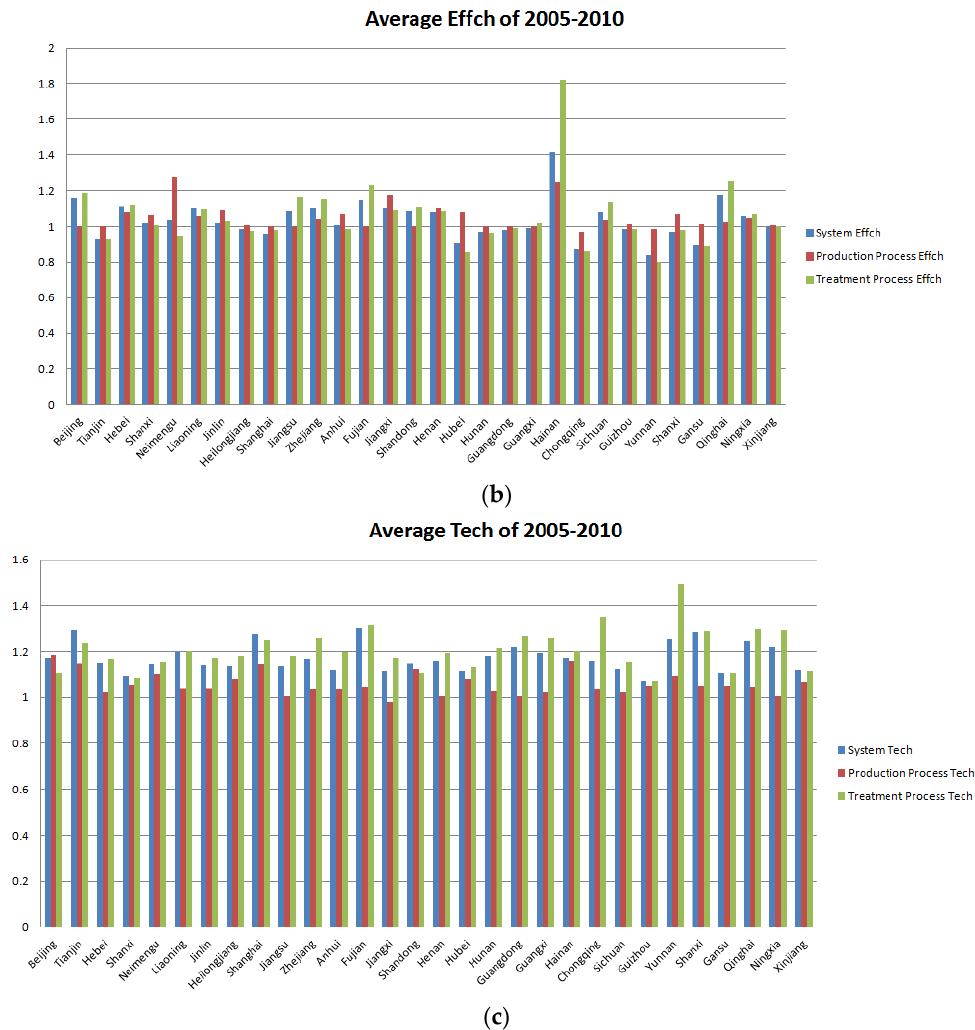
Figure 6. ( a ) Average MI index from 2005 to 2010. ( b ) Average Effch index from 2005 to 2010. ( c ) Average Tech index from 2005 to 2010.